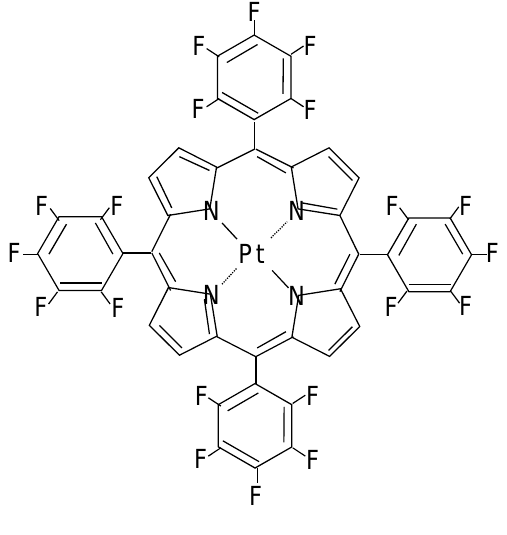
Figure 5. Chemical structure of PtTFPP. F: fluorine, Pt: platinum, and N: nitrogen,